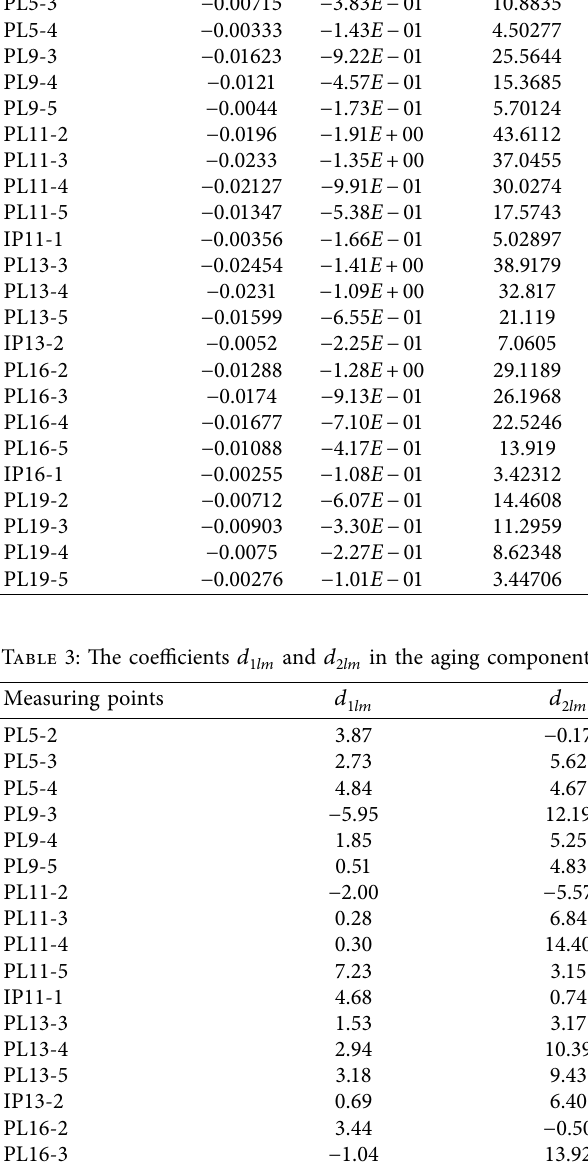
c and actual coefficient of